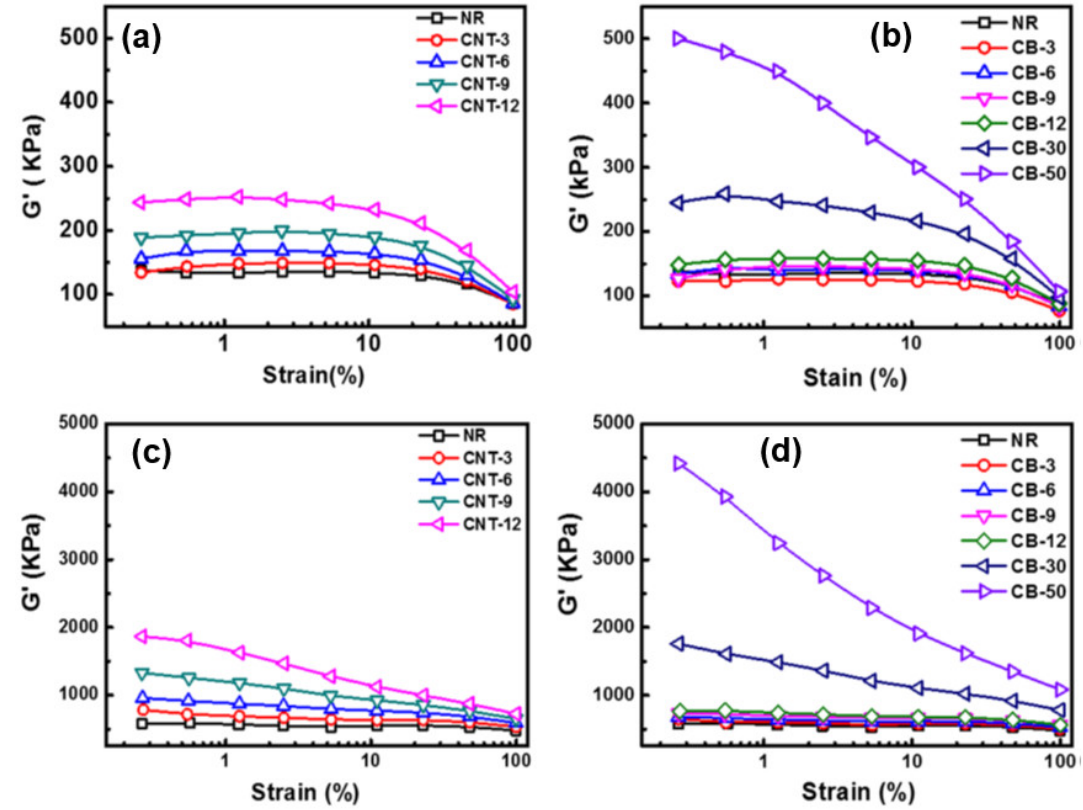
Figure 22. The strain dependence of G′ of CNT/NR and CB/NR rubber compounds ( a , b ) and vulcanizates ( c , d ). Reproduced with permission from [172], Copyright Springer, 2017.